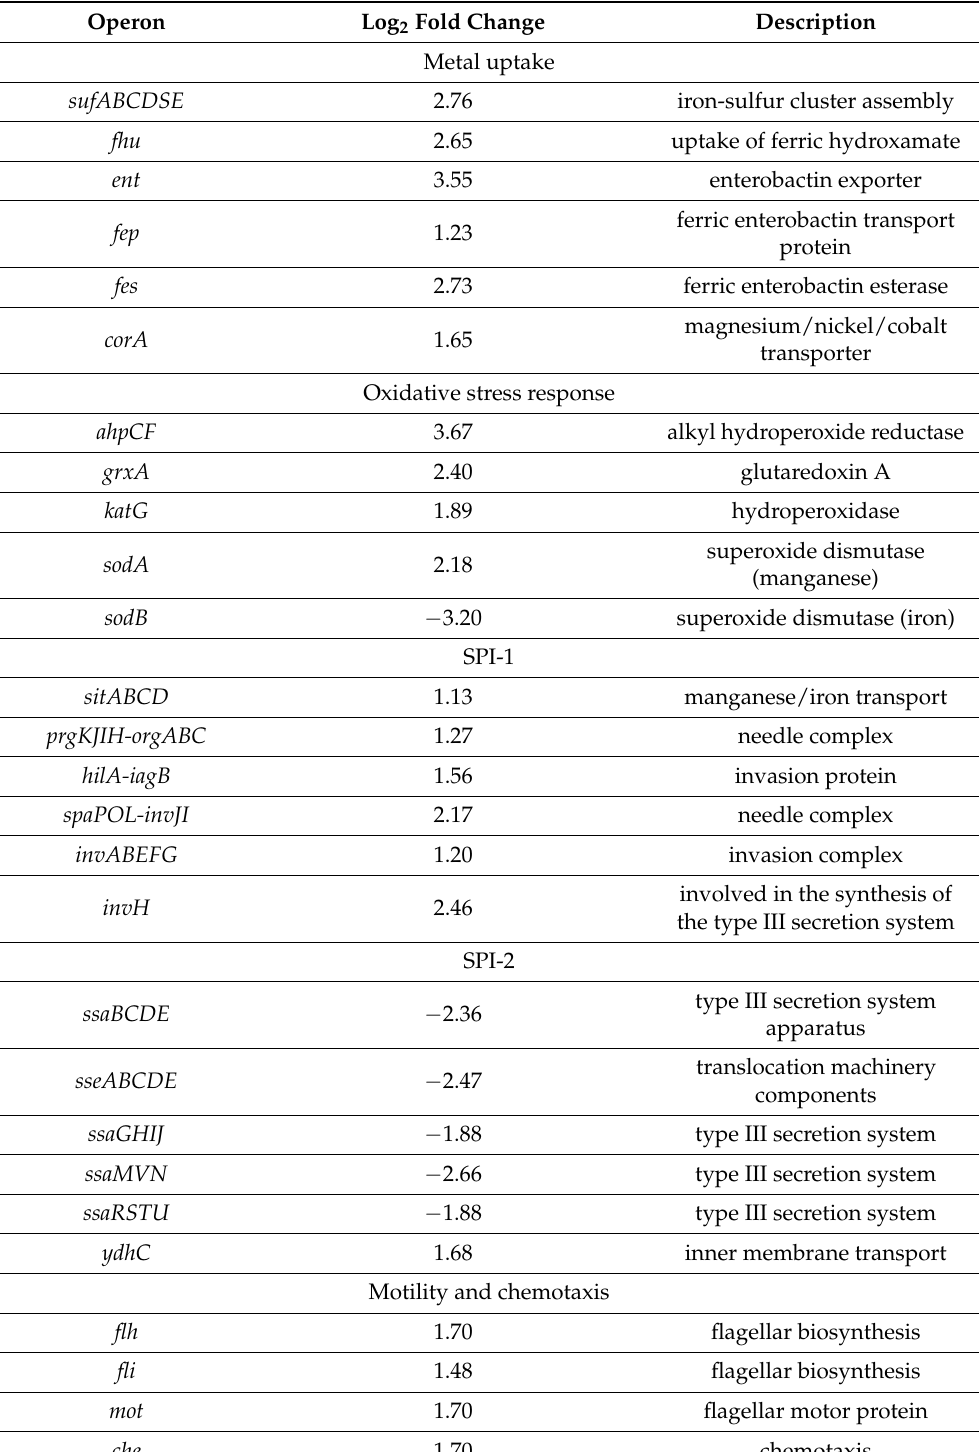
Table 1. Selected operons and genes that were differentially expressed in Salmonella within Acan- thamoeba .